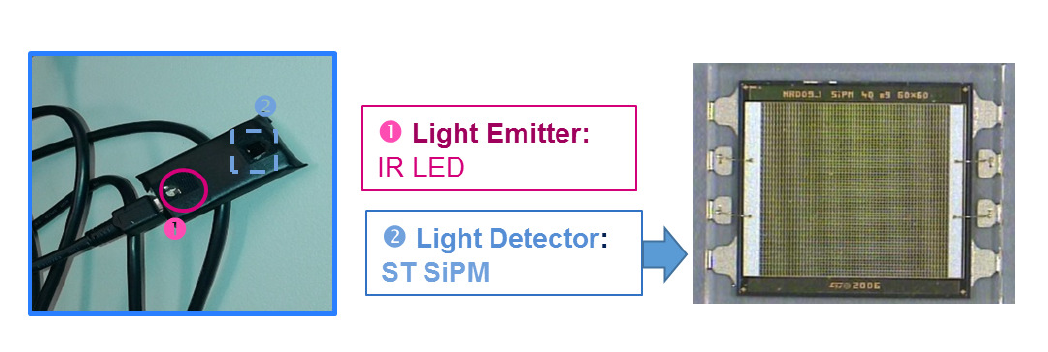
Figure 2. Silicon Photomultiplier (SiPM) detector filter and PPG probe.